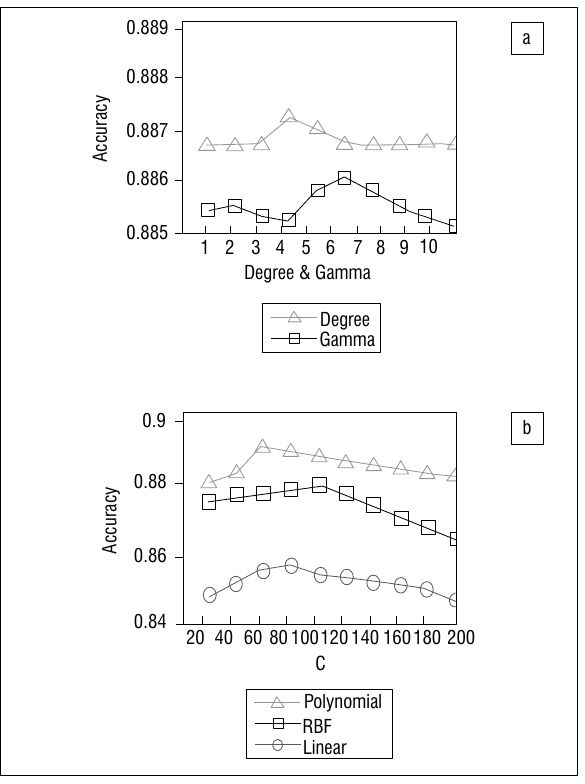
Figure 5: Cross-validation results for (a) degree and gamma and (b) penalty value, C.